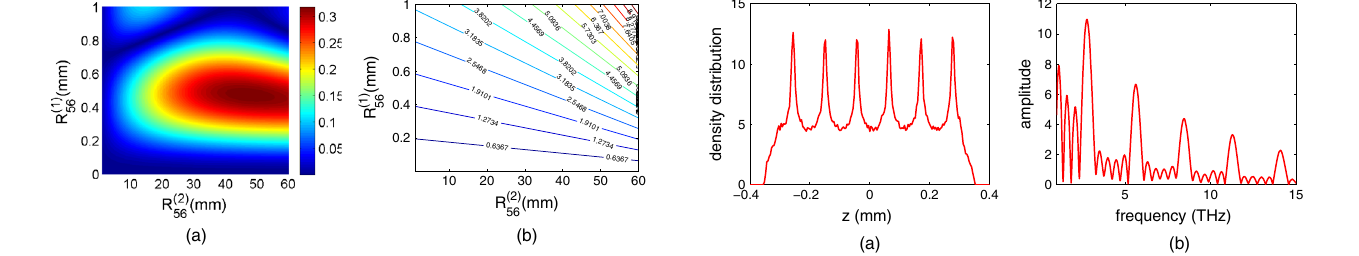
FIG. 6. Beam density distribution and its fast-Fourier-transform (FFT) image (small peaks in FFT image come from the uniform electron beam with finite length). (a) Beam density distribution.